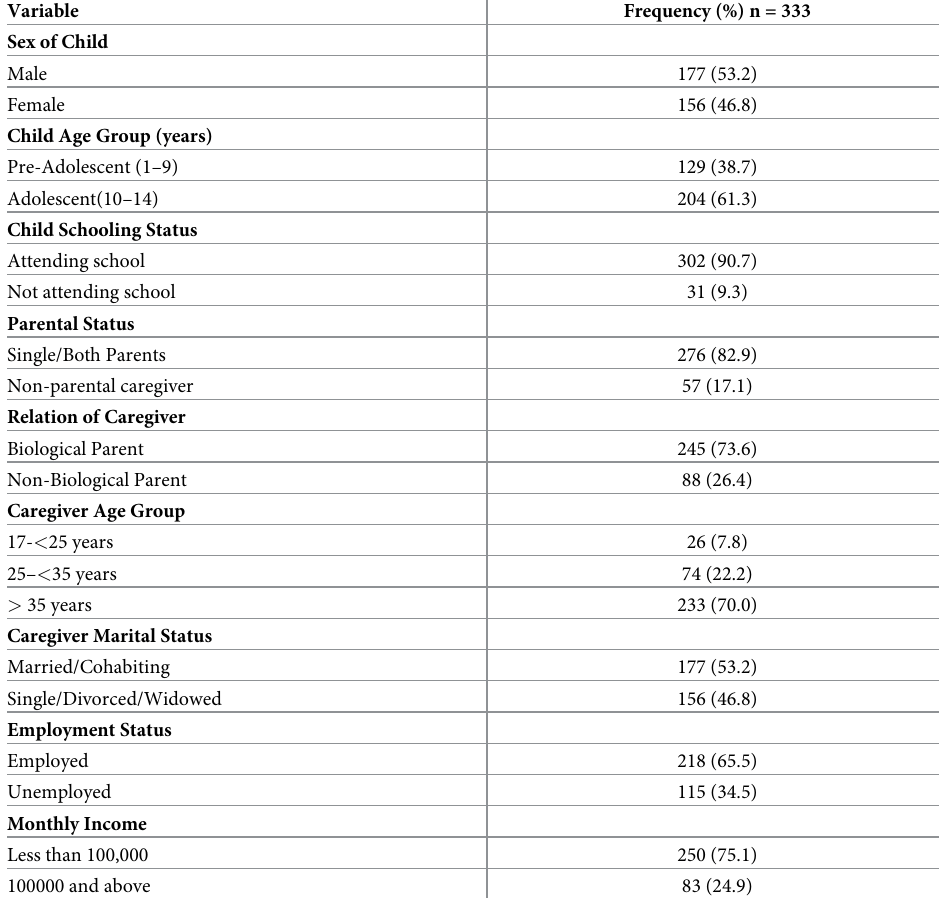
Table 1. Participant and caregiver socio-demographic